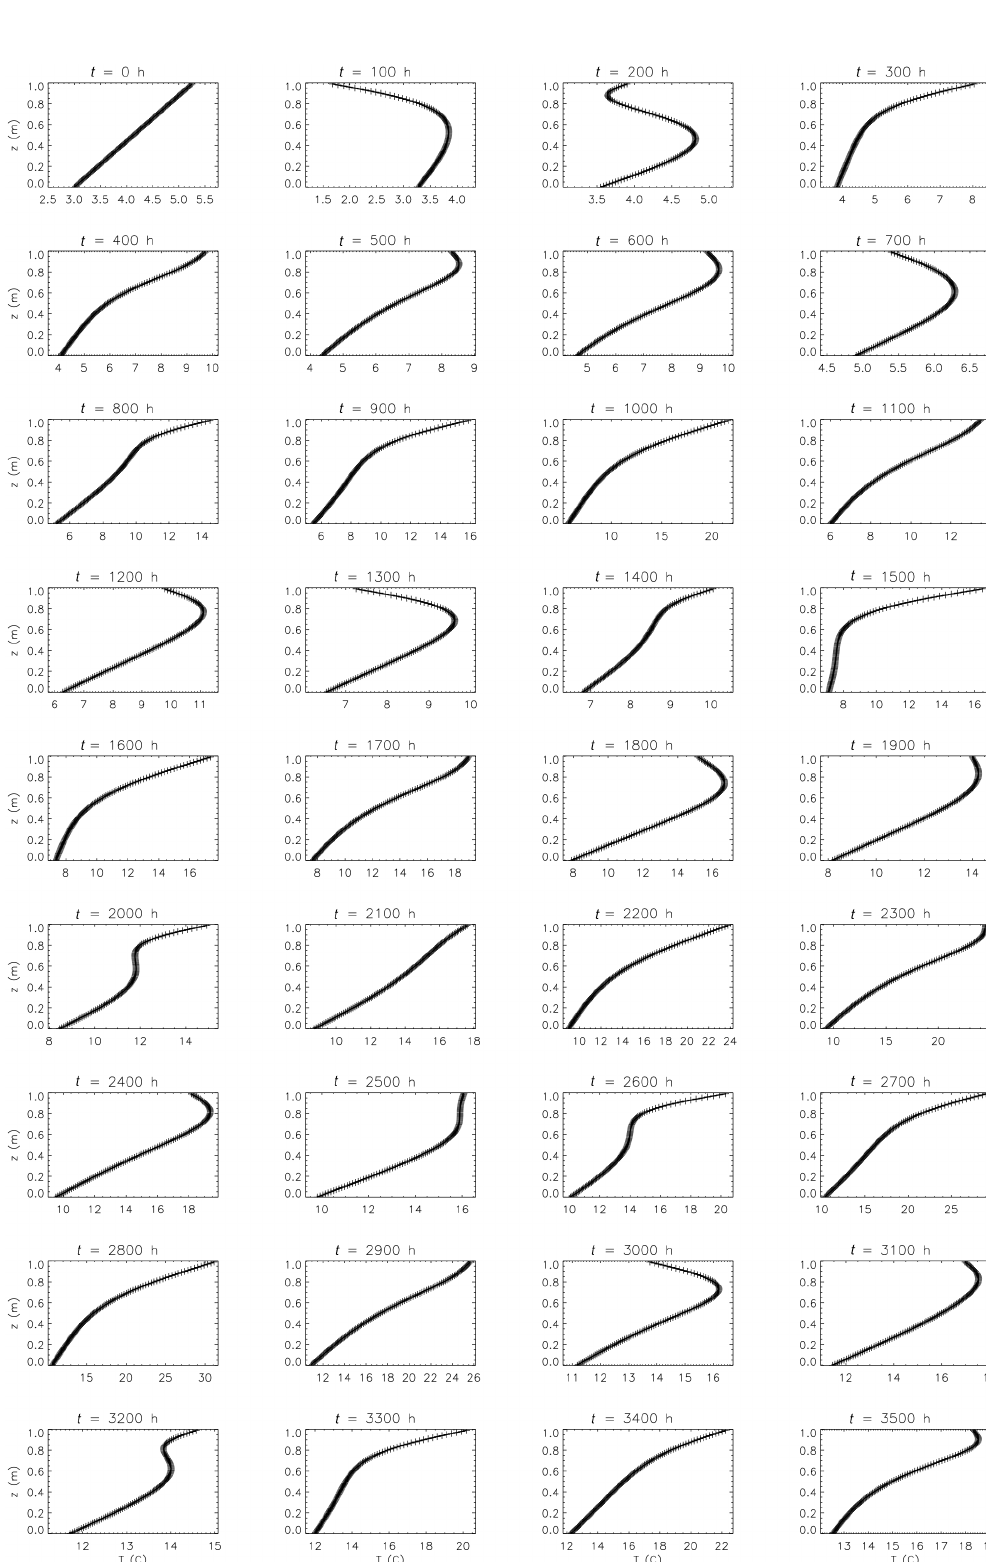
Figure 3. Comparison between soil temperature profiles obtained using the numerical ( + ) and analytical (solid line) solutions for fine spatial and temporal resolutions. Both solutions are very similar and therefore difficult to